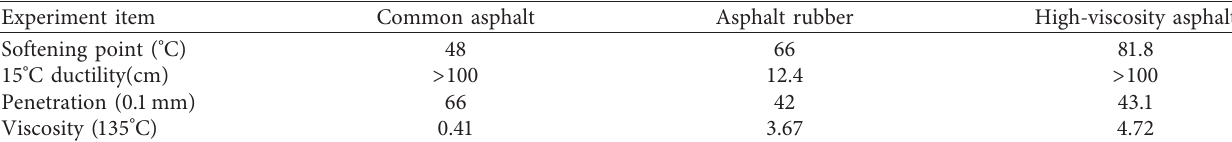
Table 3: Technical index of modified